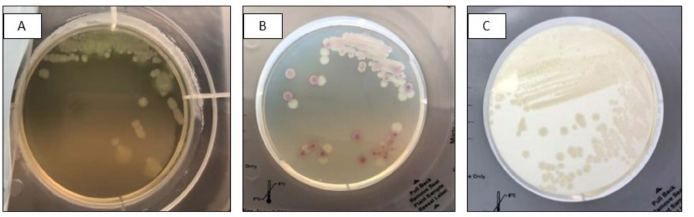
Figure 1. Mixed culture of Salmonella spp. (pink) and Pseudomonas aeruginosa (white) after subculture on InTray Colorex Screen (A) Visualization of mixed flora based on morphology; (B) Detection based on colony colour; (C) Mixed infection not detected.